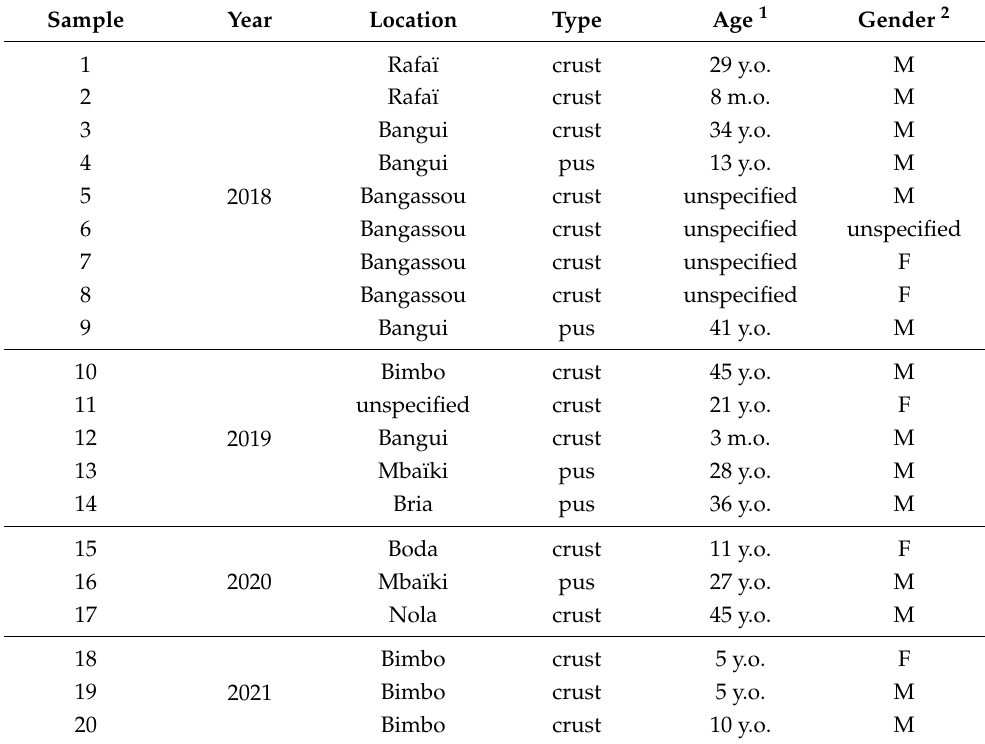
Table 1. Details of the collected varicella-zoster virus (VZV) samples. Sample Year